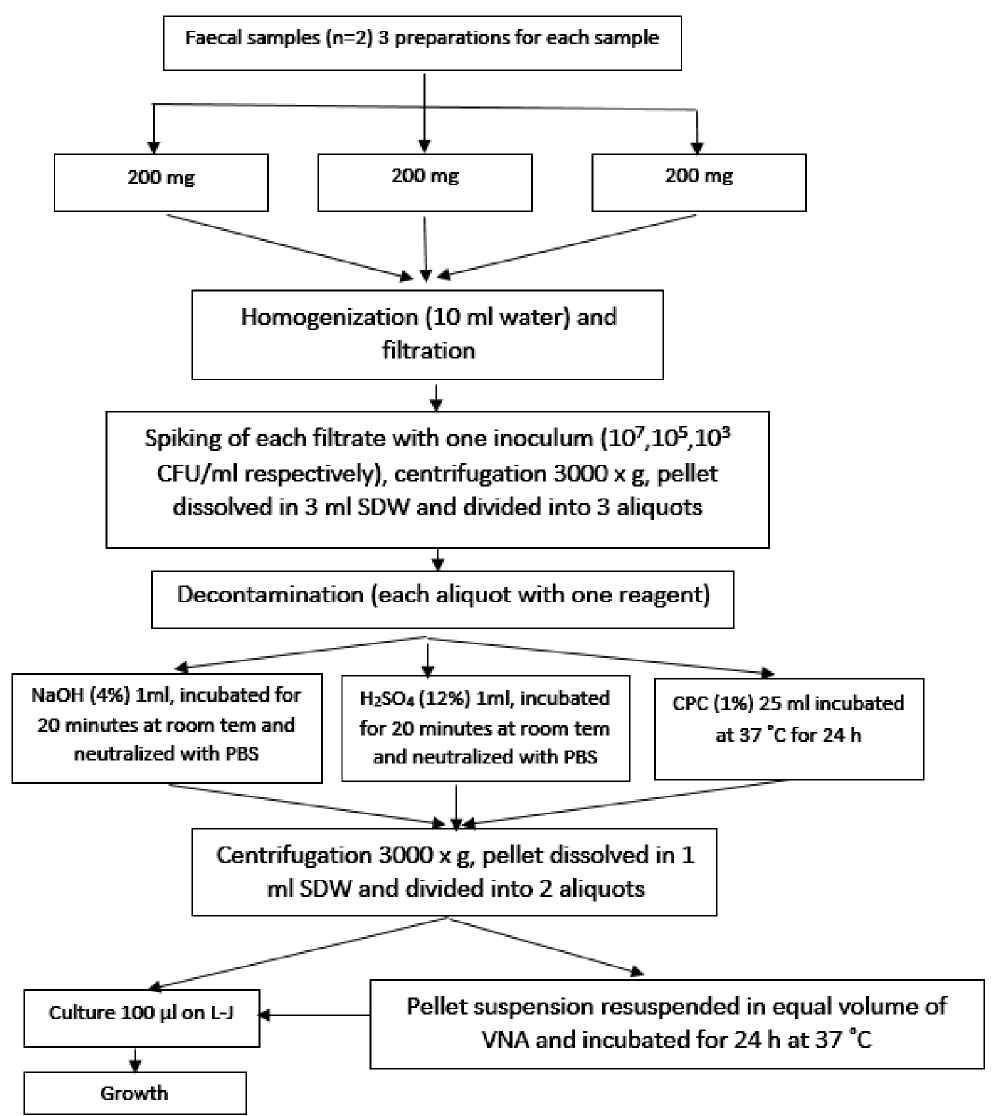
Fig 1. Schematic illustration for samples preparation, spiking with M . aviumsubsp . avium and decontamination with six procedures. evaluated for acid fast bacilli (AFB). Colonies were dissolved in a drop of normal saline and spread on a clean glass slide. The smears were air dried and heat fixed by passing the glass slide over the burner flame to ensure proper adherence. The smears were stained with Ziehl-Neel- sen stain and examined using 100× oil immersion magnification. In acid fast smears, mycobac- teria appeared as red rods in chains and clumped with a blue back ground. AFB-negative cultures were considered contaminations.